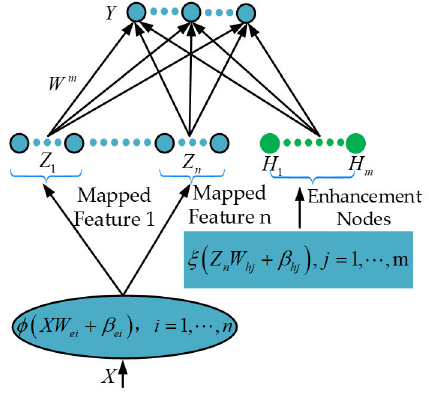
Figure 1. The structure of